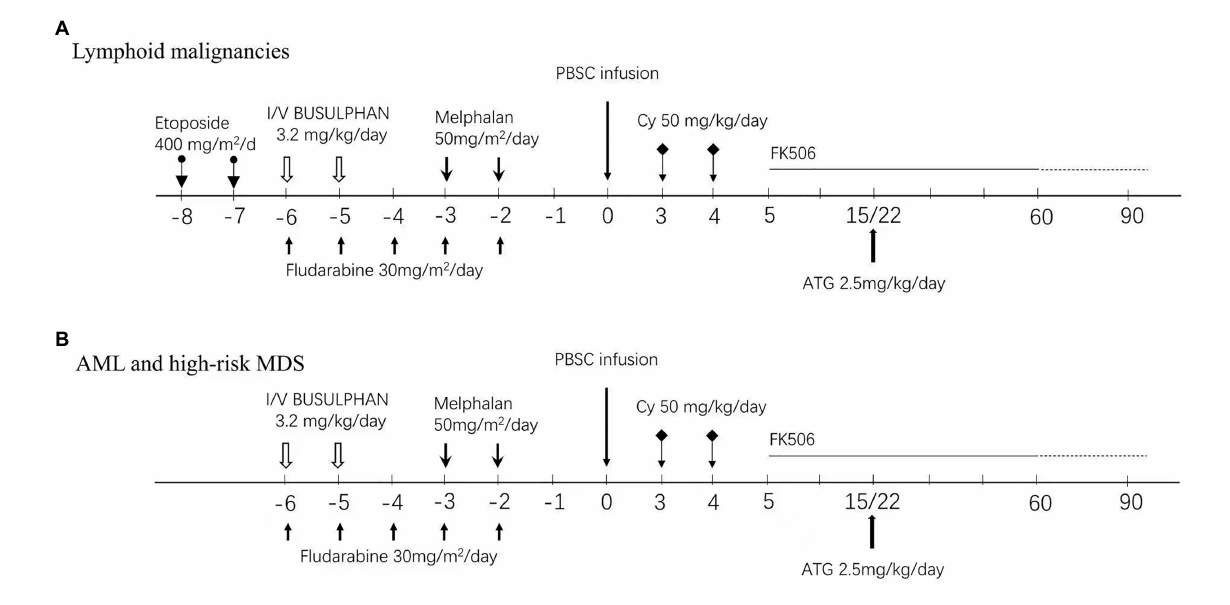
FIGURE 1 Conditioning regimens and GVHD prophylaxis protocol. (A) Lymphoid malignancies. (B) AML/high-risk MDS and CMML/Myeloid